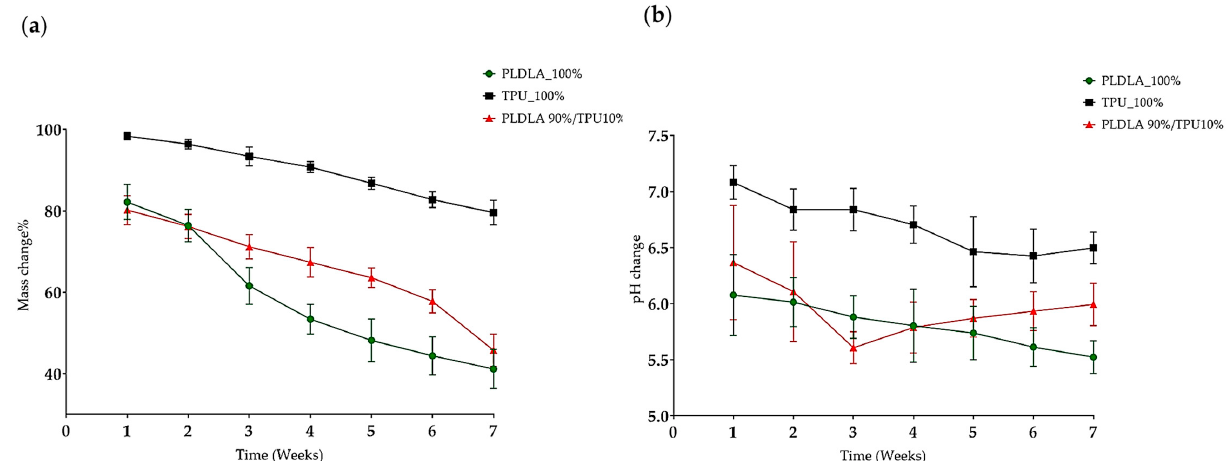
Figure 2. The mass and pH changes of the polymers PLDLA/TPU films and PLDL + TPU blend over 7 weeks incubated in simulated tear fluid (STF). ( a ); The mass changes; ( b ); The pH changes. Data points in the line plots were calculated based on the mean values of five replicates for each week interval with standard deviation error bars. In the boxplot: whiskers = 1.5 × IQR, lines = average; boxes = interquartile range Q1–Q3.